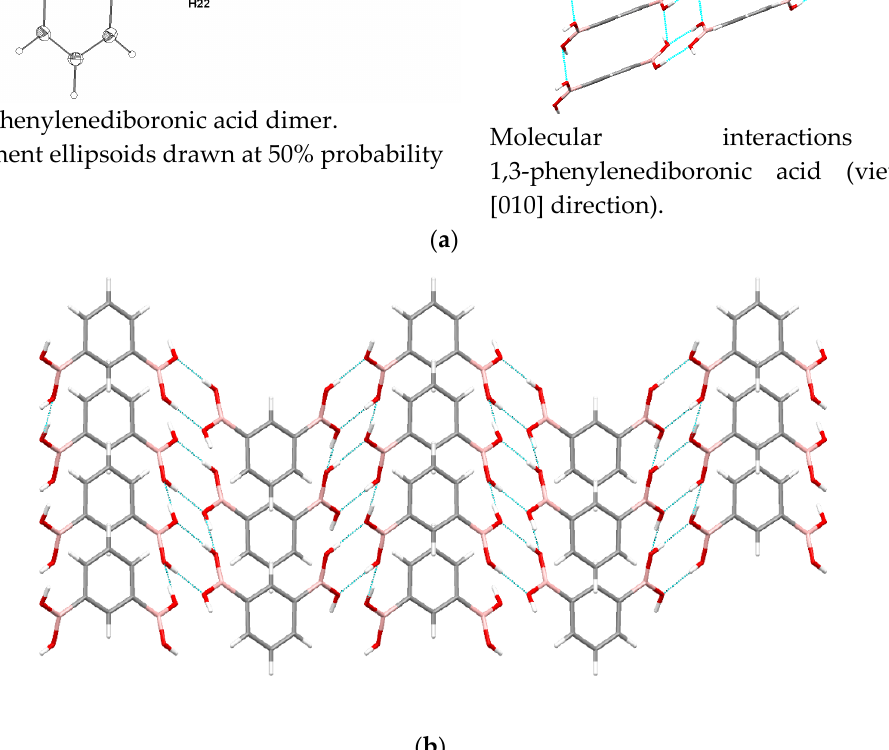
Figure 6. Infinite ribbon motif ( a ) and crystal packing of 1,3-phenylenediboronic acid ( b ).